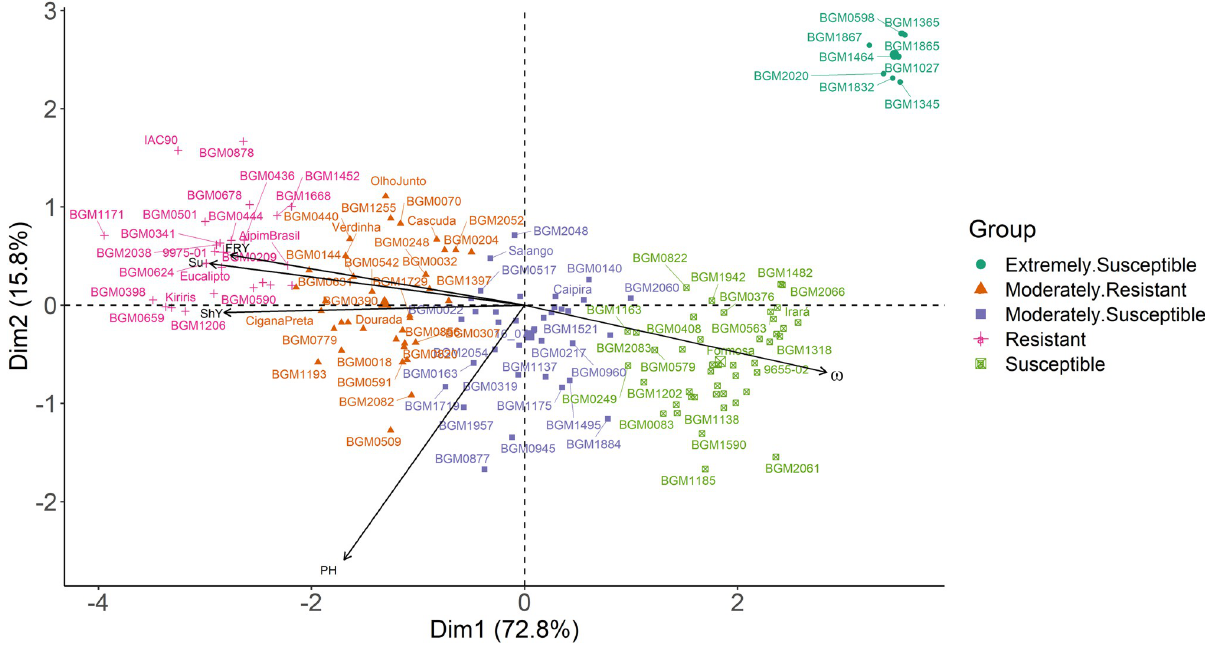
Fig 2. Principal components analysis for agronomic traits and root rot resistance in 148 cassava genotypes grown in an area naturally infested with root rot pathogens. PH: plant height (m). ShY: shoot yield (t ha -1 ). FRY: fresh root yield (t ha -1 ). ω : disease index. Su: survival (%).